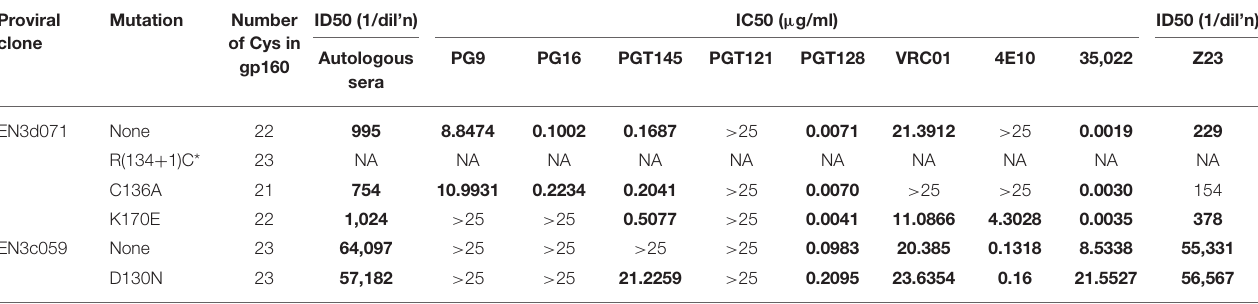
TABLE 5 | EN3 wild type and mutant pseudoviruses sensitivity to neutralization by bN-Abs and autologous sera. Proviral Mutation Number clone of Cys in